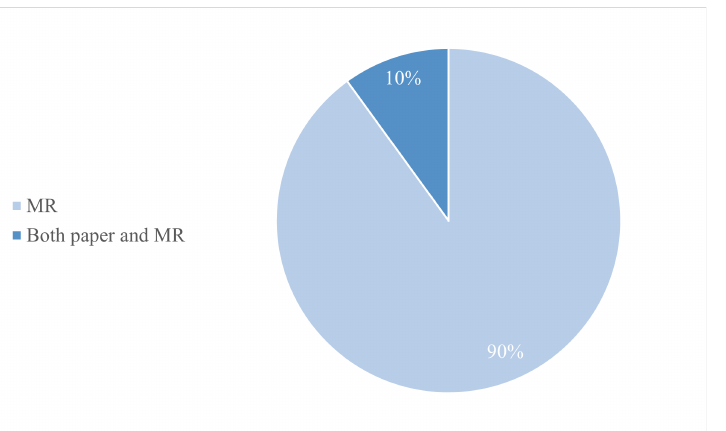
Figure 23. Answers to the question “Did you find it more obvious what component to select using MR instructions or paper